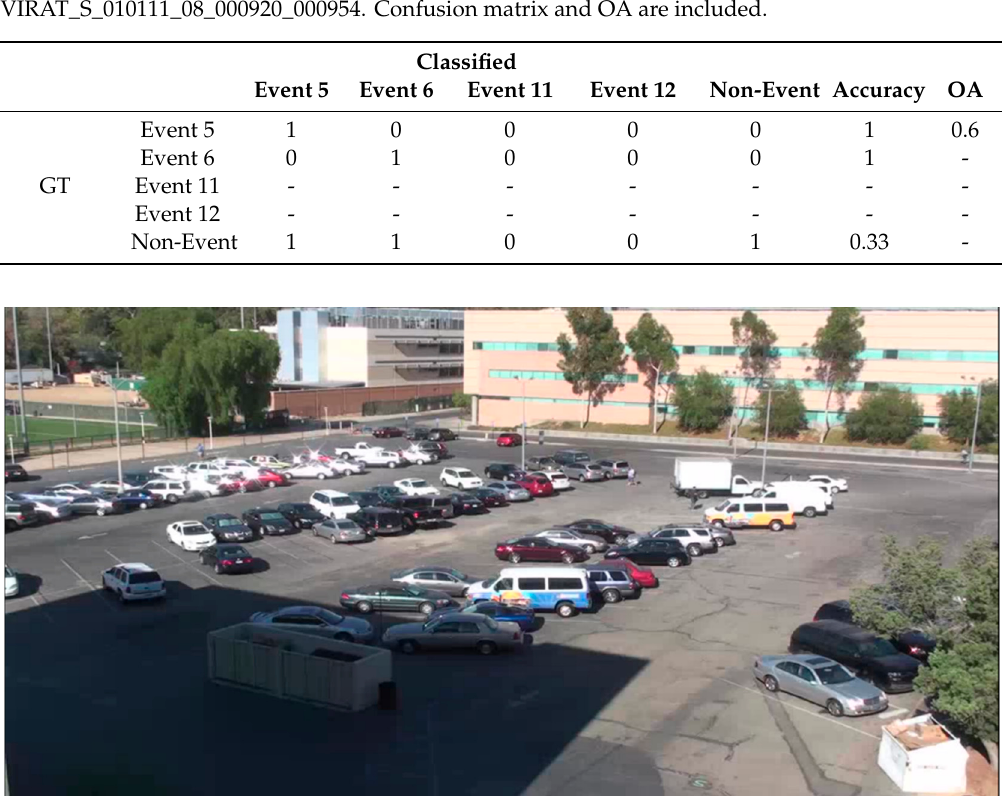
to the presence of multiple events. the presence of multiple